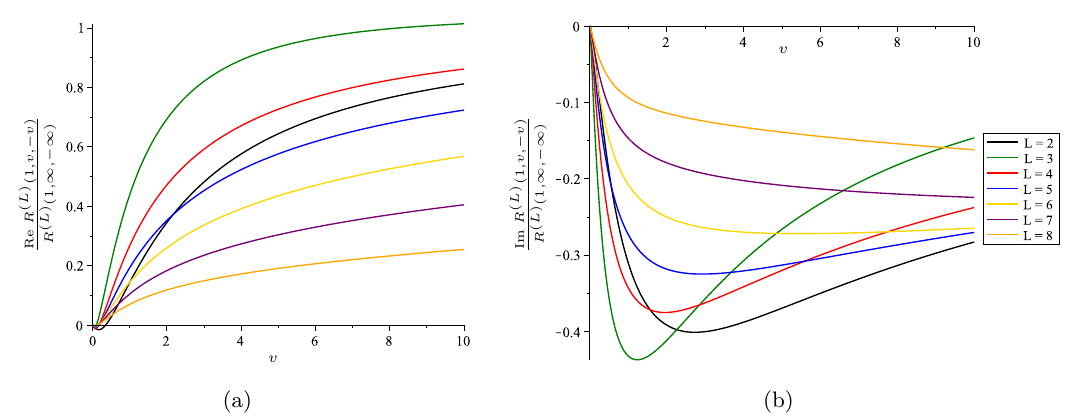
Figure 7. The real (a) and imaginary (b) parts of the remainder function R ( L ) on the line u = 1 in scattering region IIa, where v > 0 . We normalize these functions by their value at v = ∞ , where they are real.